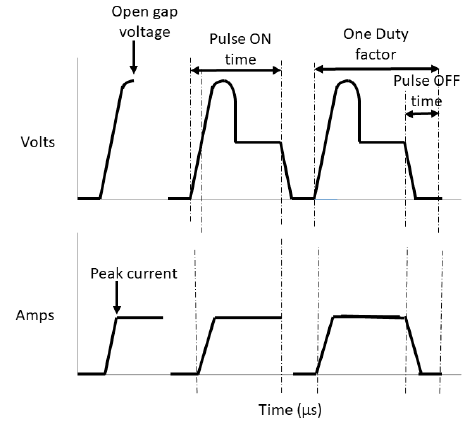
Figure 6. Representation of EDM parameters on voltage–current waveform